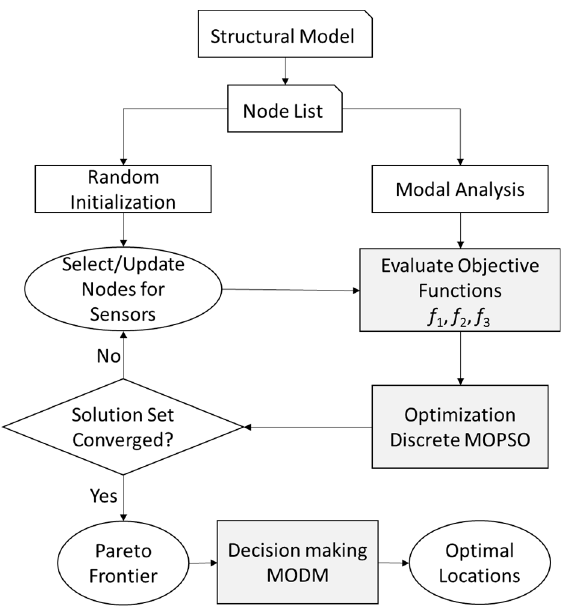
Figure 1. Flowchart of proposed method.